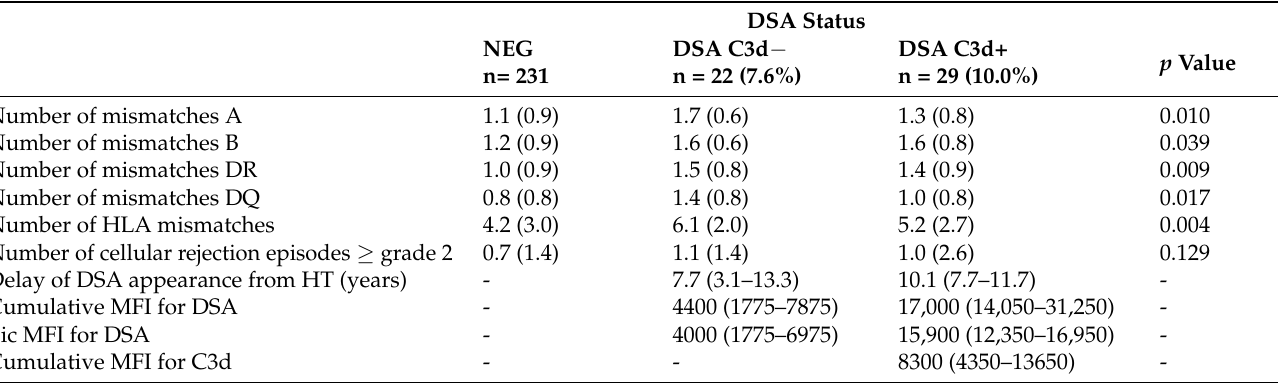
Table 2. Immunological factors according to DSA